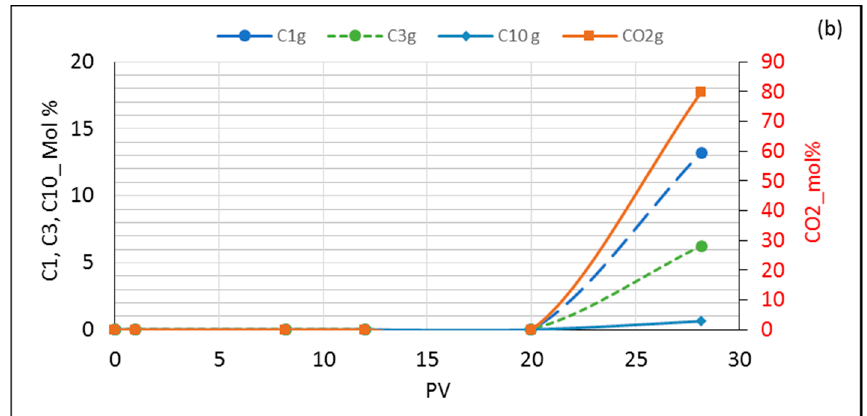
Figure 6. Dynamic composition changes as a function of the injected pore volume of CO 2 /C1/C3 into model oil (n-C10), ( a ) in liquid phase and ( b ) in the vapor phase.